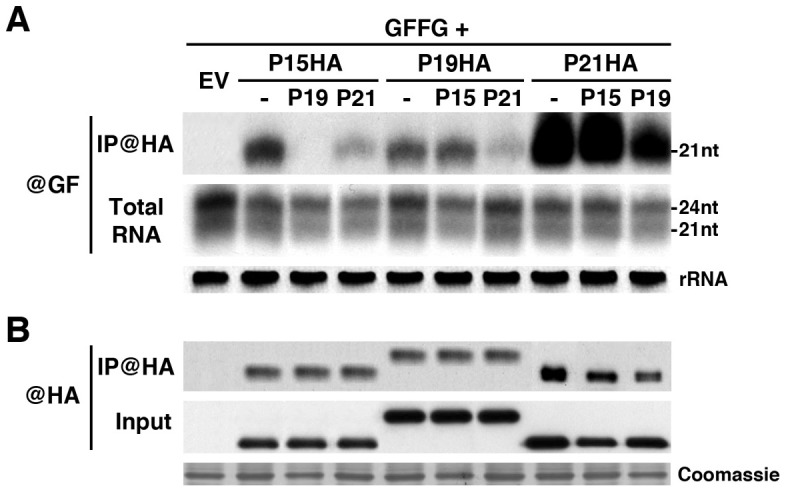
Differential effects of co-expressed VSRs on P19 siRNA-binding capacity.(A) RNA gel blot analysis of GF siRNA accumulation (@GF) in total RNA and HA immunoprecipitated fractions from Nicotiana benthamiana infiltrated leaves expressing HA-tagged P15, P19 or P21 VSRs, either alone (-) or in combination with untagged VSRs. Ethidium bromide staining of ribosomal RNA (rRNA) is used as loading control. (B) Protein blot analysis of HA-tagged VSRs accumulation (@HA) in total (input) or immunoprecipitated fractions (IP@HA) of the samples described in (A). Coomassie staining of the membrane was used to verify equal loading after western blotting. EV: empty vector. Experiments were repeated three times and gave similar results.